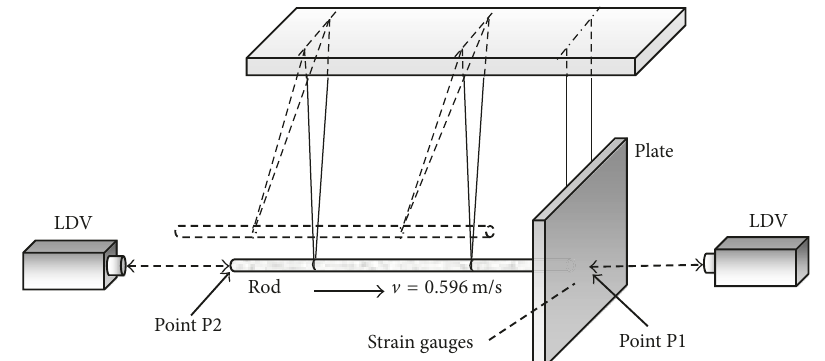
Figure 3: Schematic diagram of the normal experiment.